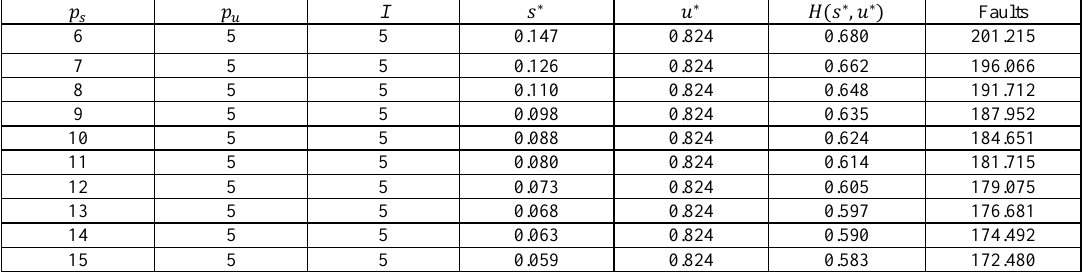
Table 5. The result of sensitivity analysis